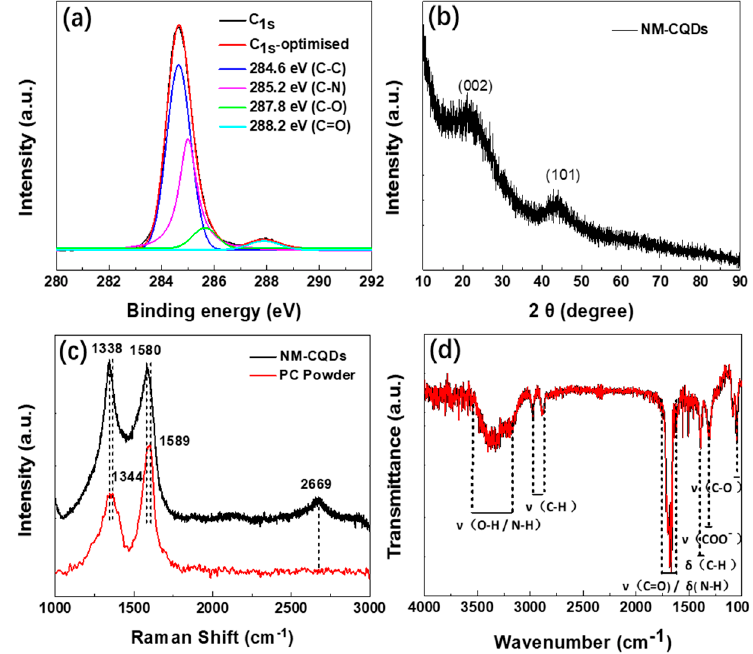
Figure 3. ( a ) High-resolution C 1 s spectrum of NM-CQDs (red curve), and four fitting components (blue, magenta, green, and cyan curves). ( b ) X-ray diffraction (XRD) patterns of NM-CQDs. ( c ) Raman spectra of NM-CQDs and PC powder with an excitation wavelength of 532 nm. ( d ) Fourier-transform infrared (FTIR) spectrum of NM-CQDs.